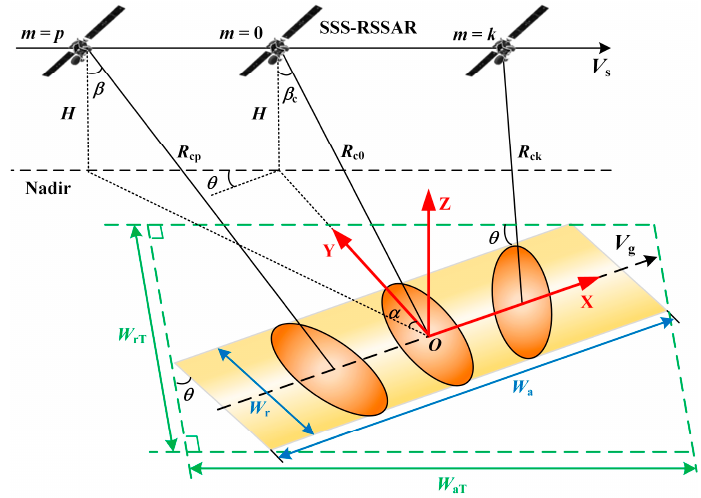
Figure 2. SSS-RSSAR data acquisition geometry.